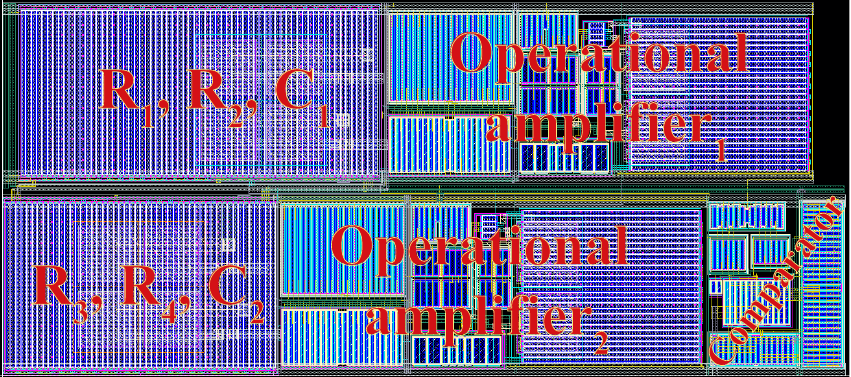
Figure 9. Layout of the proposed ADSM.